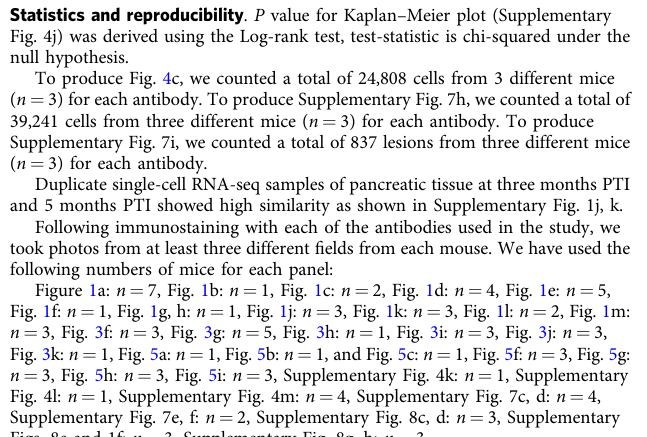
Figure 1a: n = 7, Fig. 1b: n = 1, Fig. 1c: n = 2, Fig. 1d: n = 4, Fig. 1e: n = 5, Fig. 1f: n = 1, Fig. 1g, h: n = 1, Fig. 1j: n = 3, Fig. 1k: n = 3, Fig. 1l: n = 2, Fig. 1m: n = 3, Fig. 3f: n = 3, Fig. 3g: n = 5, Fig. 3h: n = 1, Fig. 3i: n = 3, Fig. 3j: n = 3, Fig. 3k: n = 1, Fig. 5a: n = 1, Fig. 5b: n = 1, and Fig. 5c: n = 1, Fig. 5f: n = 3, Fig. 5g: n = 3, Fig. 5h: n = 3, Fig. 5i: n = 3, Supplementary Fig. 4k: n = 1, Supplementary Fig. 4l: n = 1, Supplementary Fig. 4m: n = 4, Supplementary Fig. 7c, d: n = 4, Supplementary Fig. 7e, f: n = 2, Supplementary Fig. 8c, d: n = 3, Supplementary Figs. 8e and 1f: n = 3, Supplementary Fig. 8g, h: n =